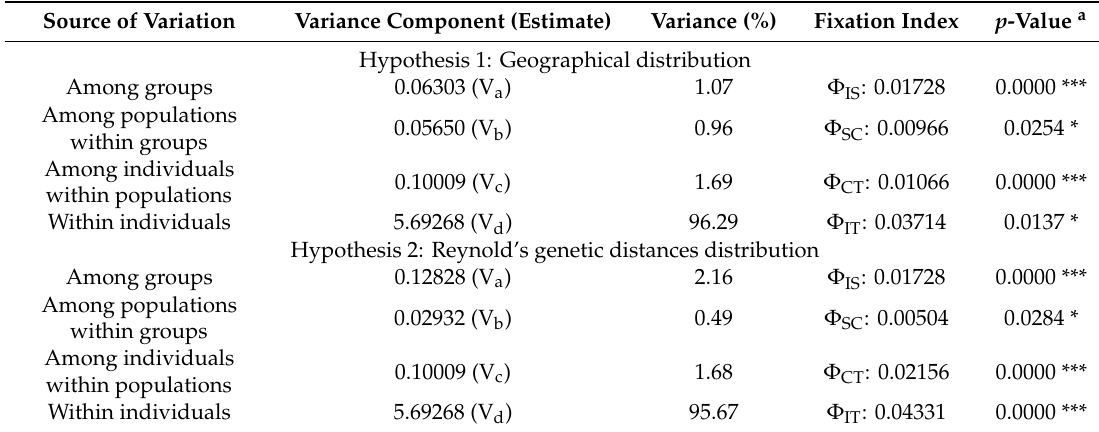
Table 5. Hierarchical AMOVA analysis among the 16 Turkish donkey